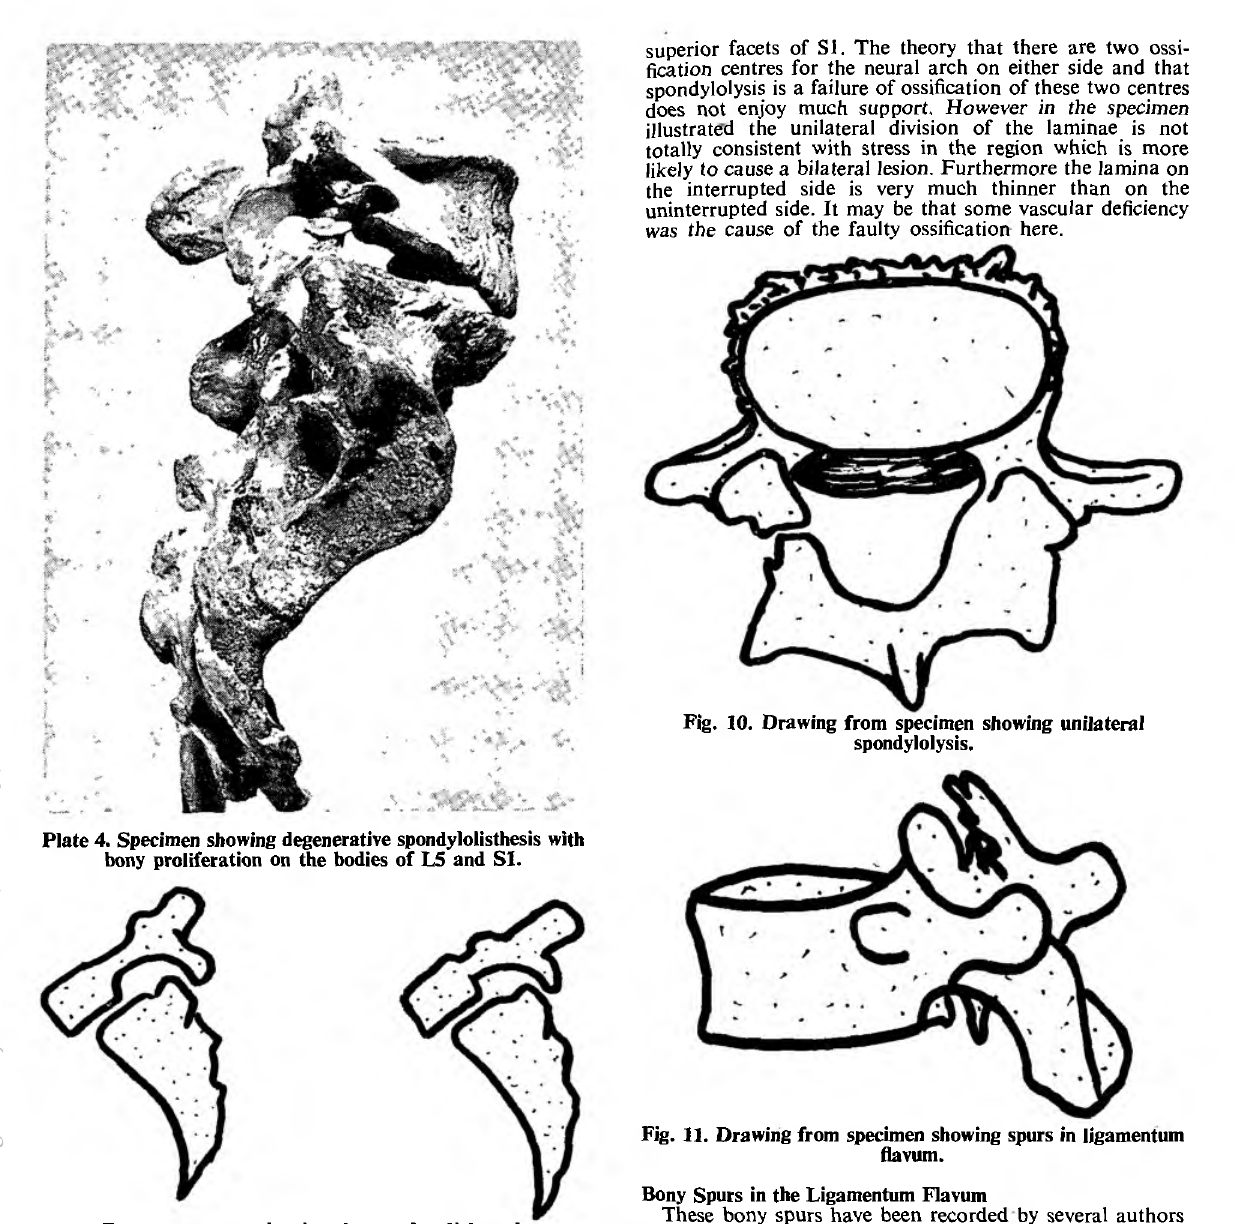
Fig. 9. Diagrams showing elongated pedicle and spondylolisthesis.